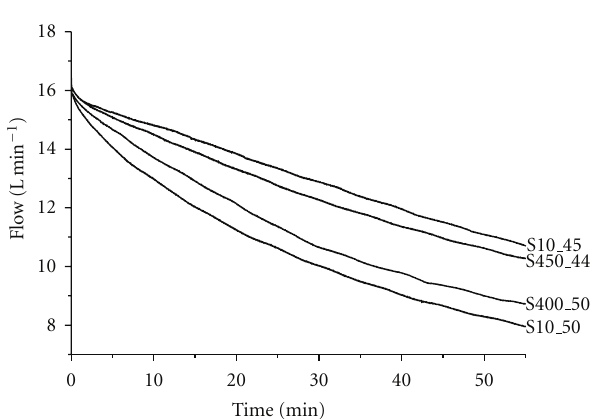
Figure 3: Gas flow through the filter element as a function of time for the fuels S10 45, S10 50, S450 45, and S400 50.